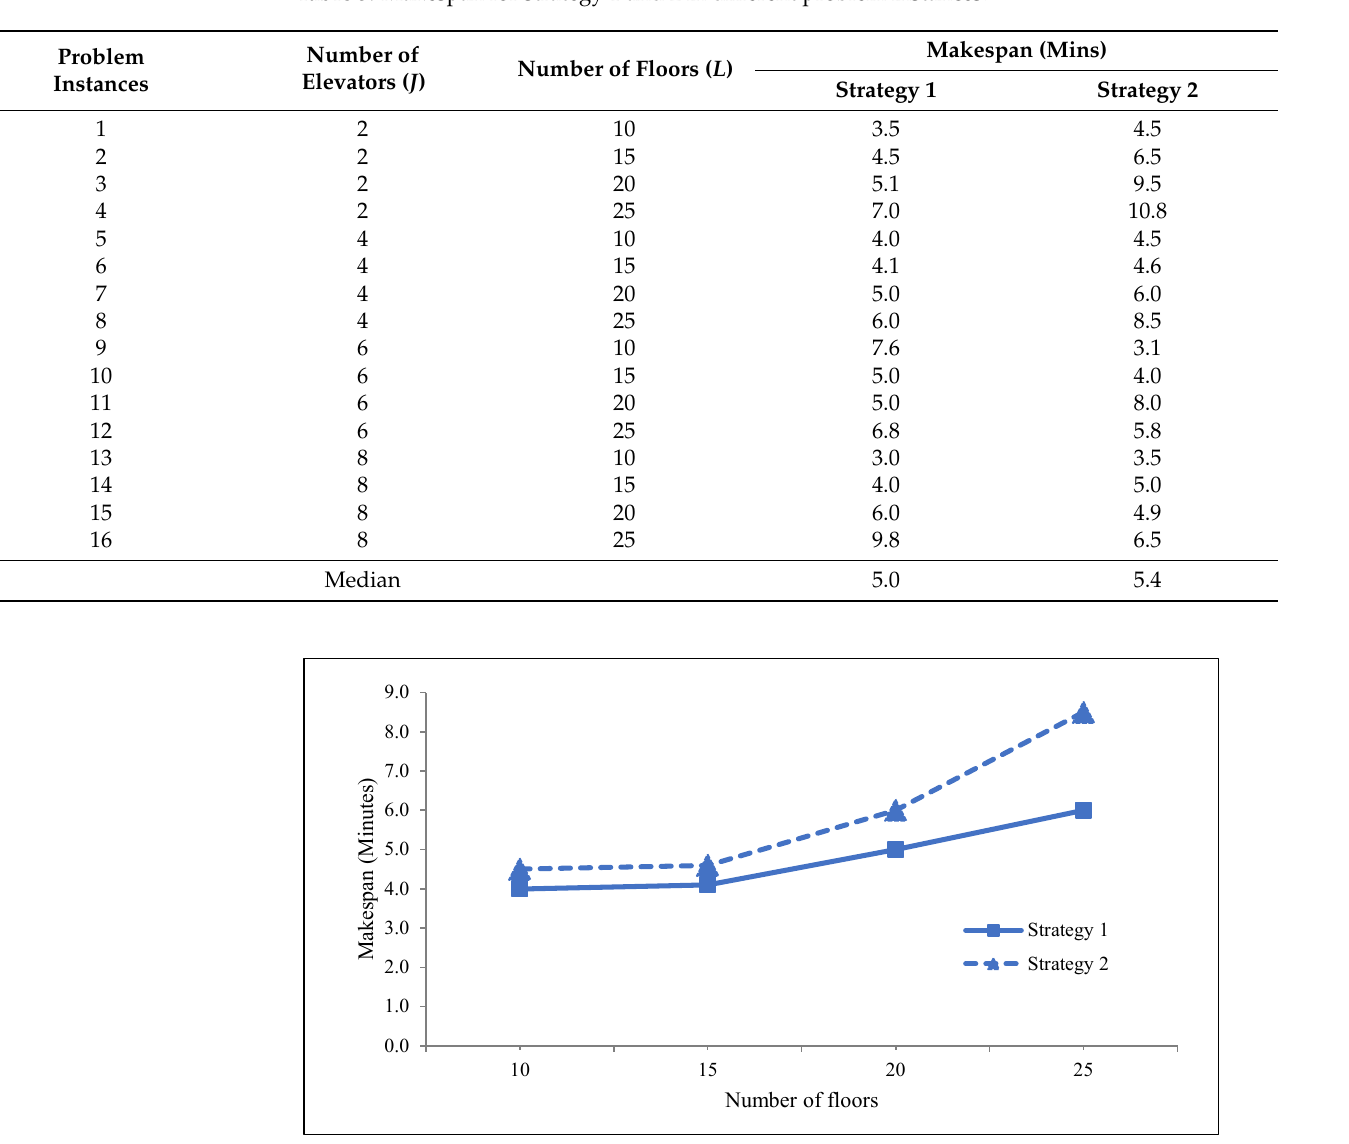
Figure 4. Makespan against number of fl oors ( 𝐼 = 20 , 𝐽 = 4 , 𝐾 = 10 ). Table 5. Makespan for strategy 1 and 2 in di ff erent problem instances.